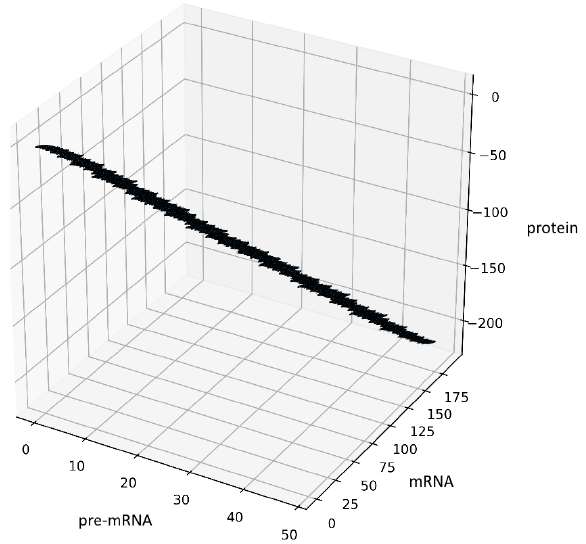
, b = 3 , c = 2 , δ = 1, the 2 3 4